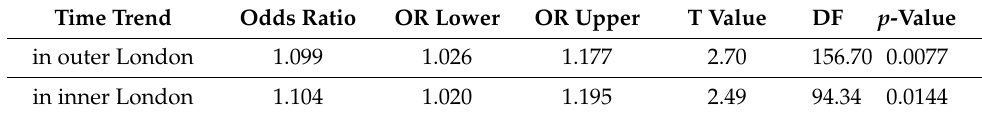
Table 2. Time trend by inner and outer London, Odds